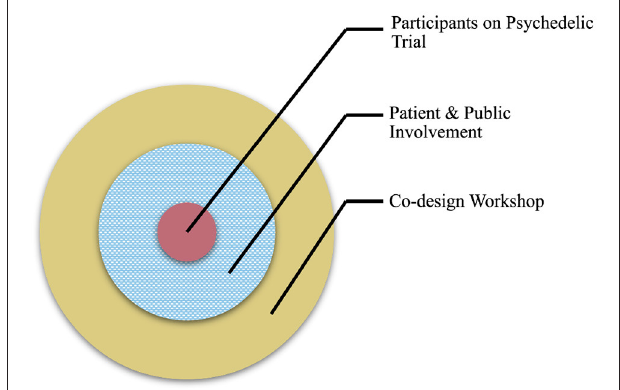
FIGURE 1 | A diagram to illustrate the aim of the co-design workshop. Workshop activities (outer ring) focused on issues related to public contributors and PPI in psychedelic research (middle ring), rather than participants enrolled on a psychedelic study (inner